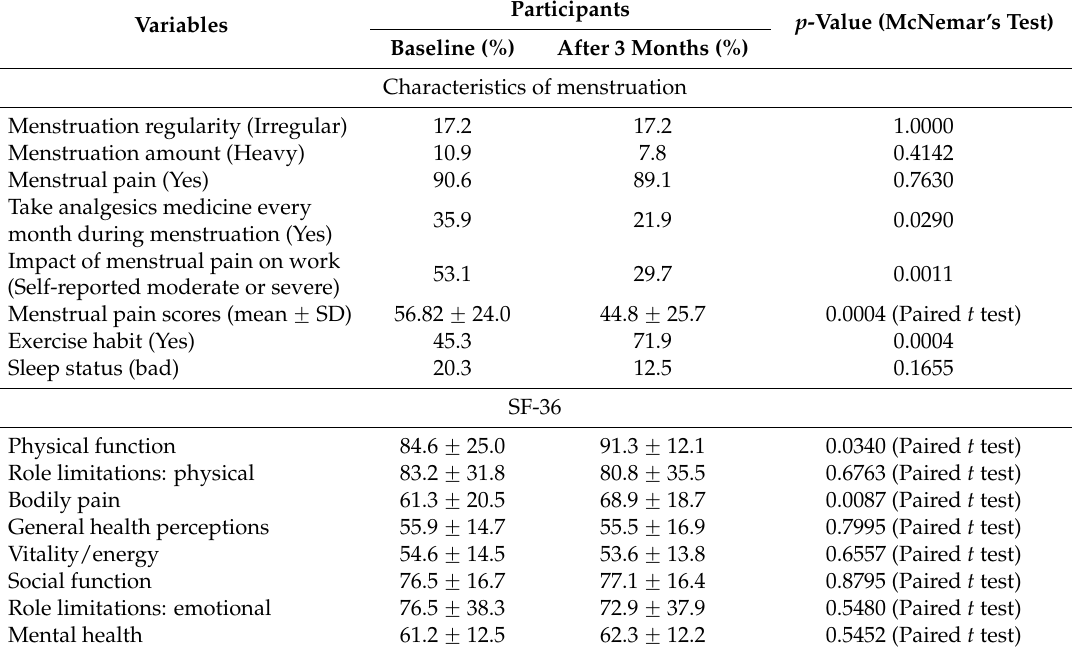
Table 2. Comparison of characteristics of menstruation, exercise habit, sleep status, and SF-36 scores at baseline and after 3 months yoga exercise